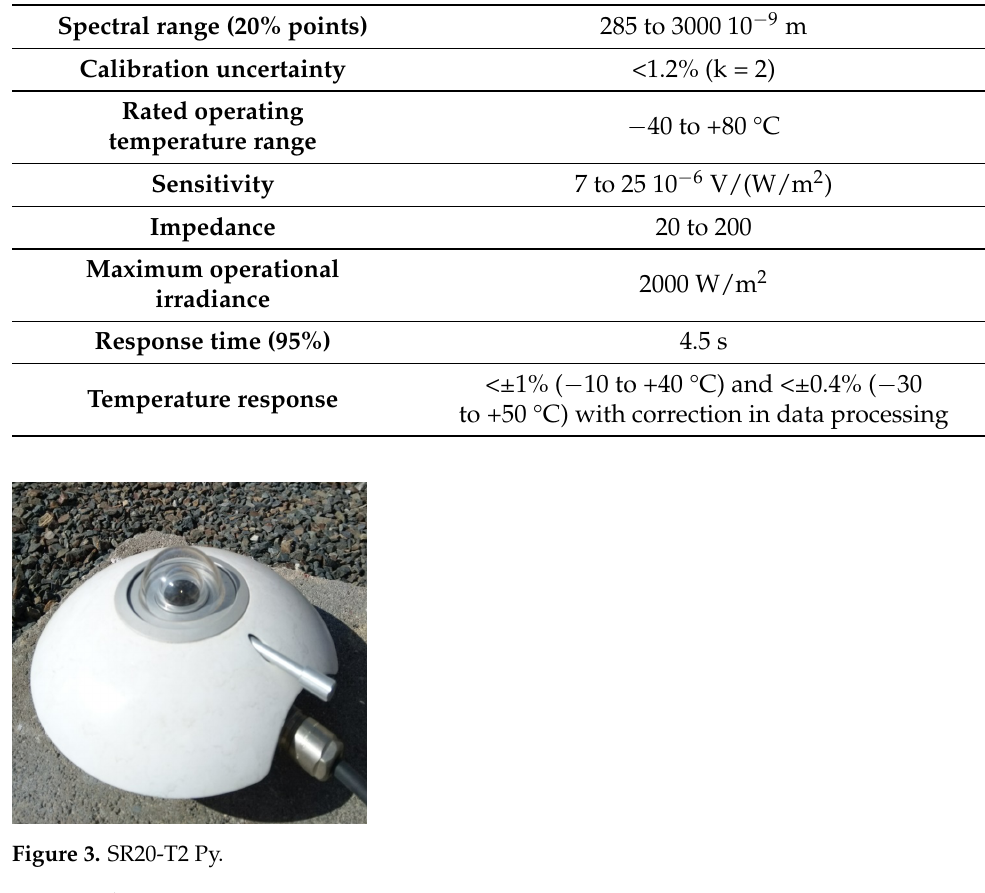
Table 3. SR20-T2 Py Specifications.